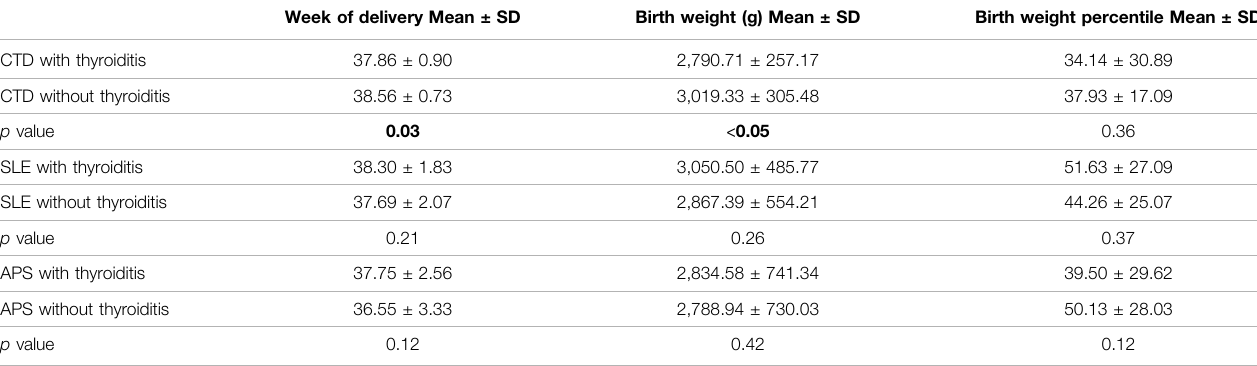
The bold values represent the statistically signi fi cant